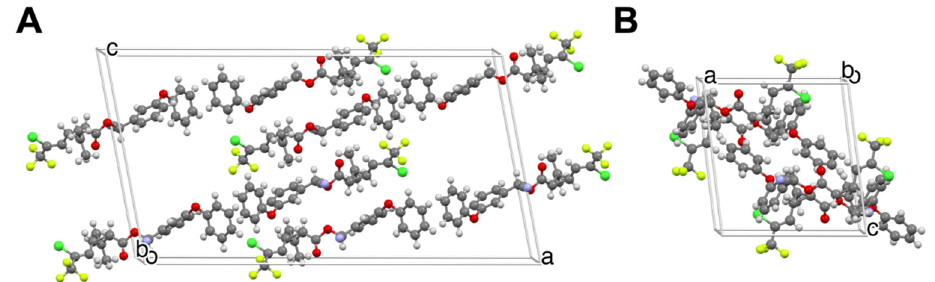
Figure 4. Crystal structure of ɑ -cypermethrin Form I.